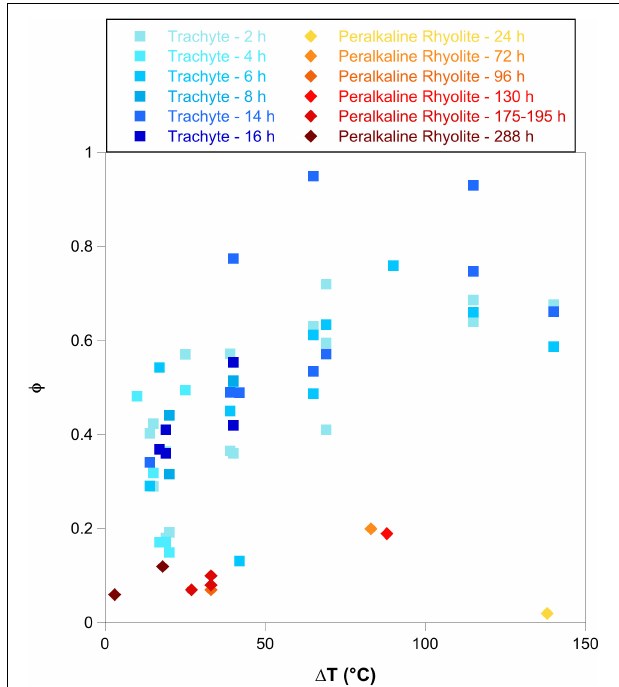
FIGURE 8 | Crystal fraction of alkali feldspar ( φ ) as function of (cid:49) T. The diagram displays a comparison between alkali feldspar crystal fraction obtained in this study (Peralkaline rhyolite in redish squares) and φ obtained by cooling and decompression experiments in trachytic melts (bluish squares) (Arzilli and Carroll, 2013; Arzilli et al.,